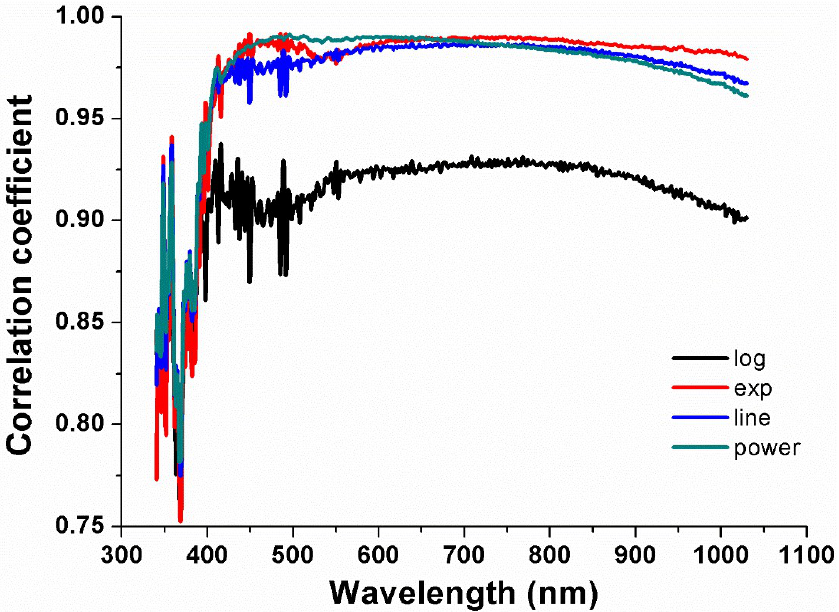
Figure 10. The changes of c orrelation coefficients of the spectral ratio with soil moisture content over wavelength.